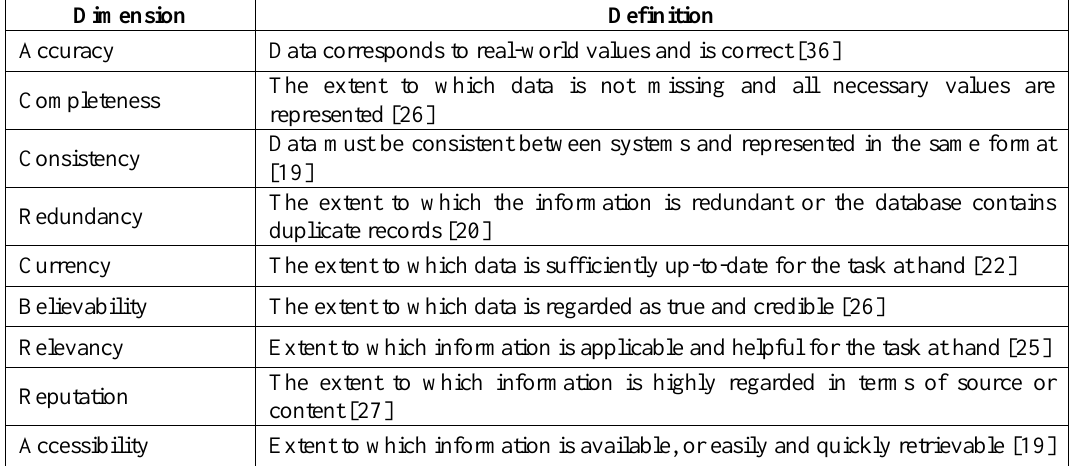
Table 1. Name and description of the main quality dimensions